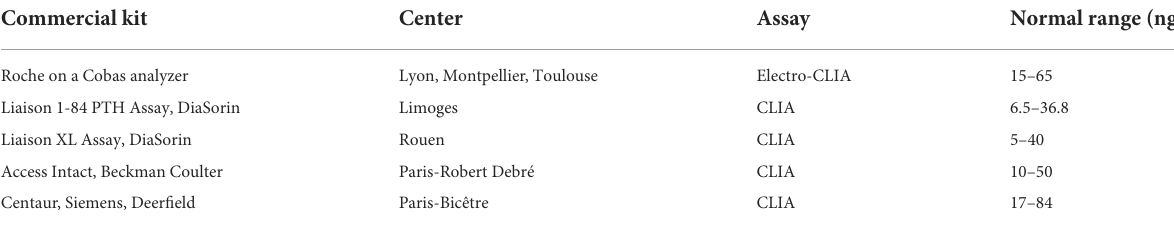
TABLE 1 Assays used for routine assessment of plasma PTH levels in different contributing